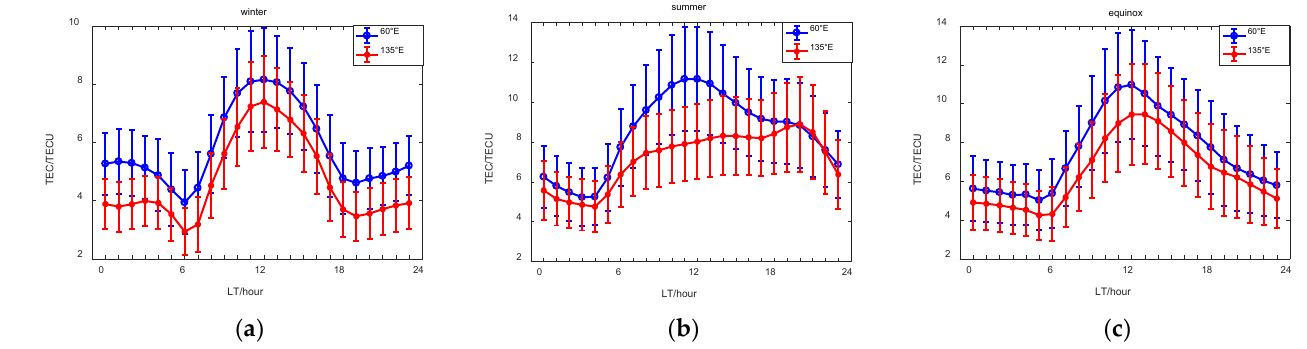
Figure 11. The diurnal variations of mean and standard deviation of TEC in the East Asian midlatitudes (60°E, 45°N–50°N; 135°E, 45°N–50°N) in ( a ) summer, ( b ) winter and ( c ) equinox in the geomagnetic quiet condition.